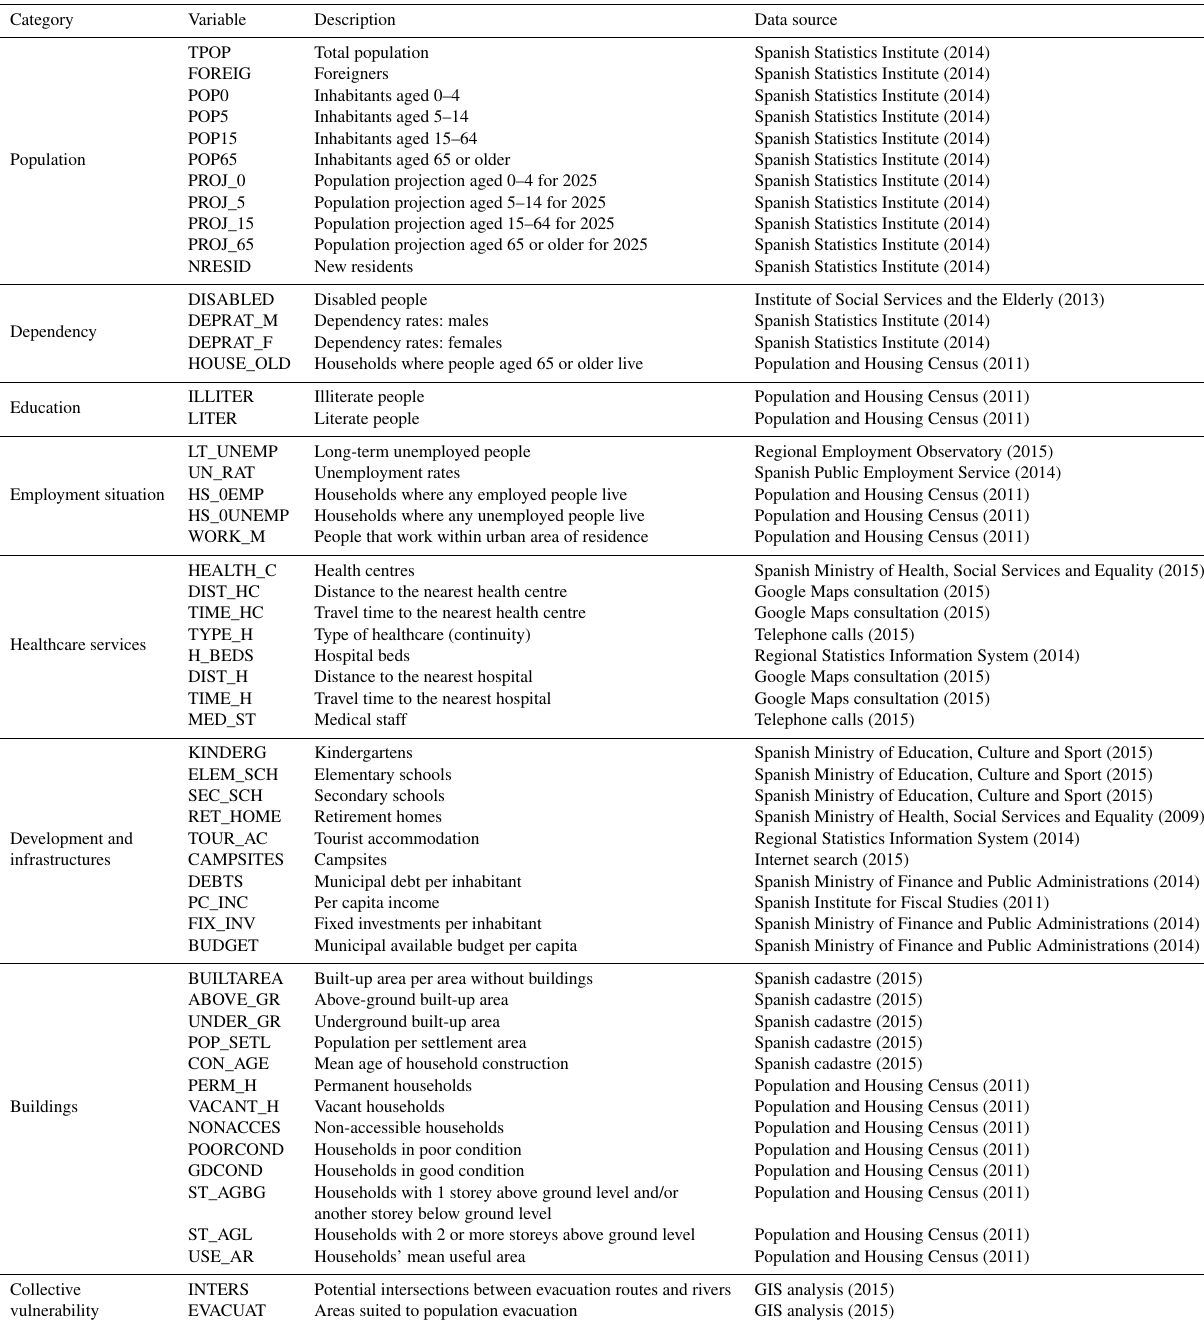
Table 1. Set of variables used in the exploratory analysis of social vulnerability